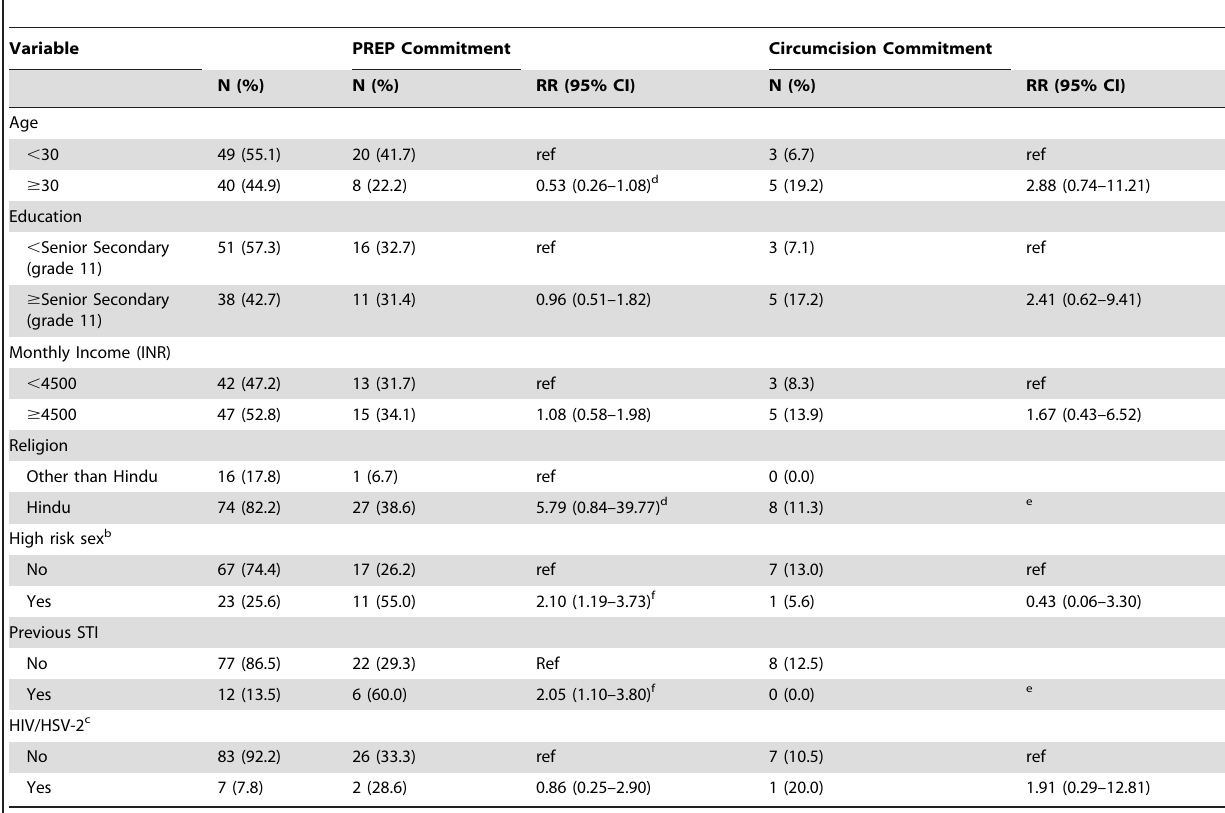
a For PREP analysis, 5 participants were excluded because of missing data and for circumcision commitment analysis 4 participants were excluded because of missing data and 14 participants because of previous circumcision history. b History of concurrent sexual relationship or contact with female sex worker. c HIV or HSV-2 seroprevalence. d p , 0.10. e Model did not converge.